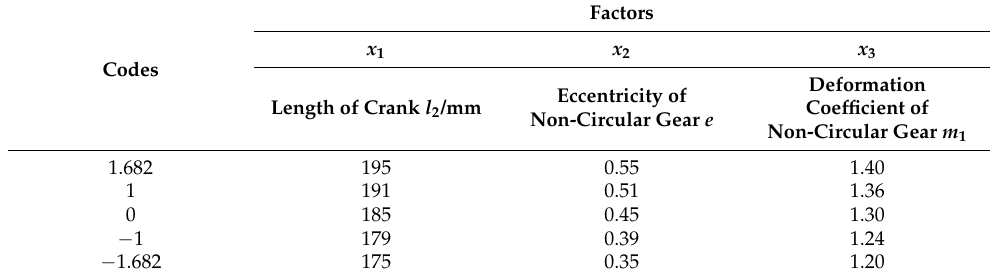
Table 5. Experimental factors and codes.